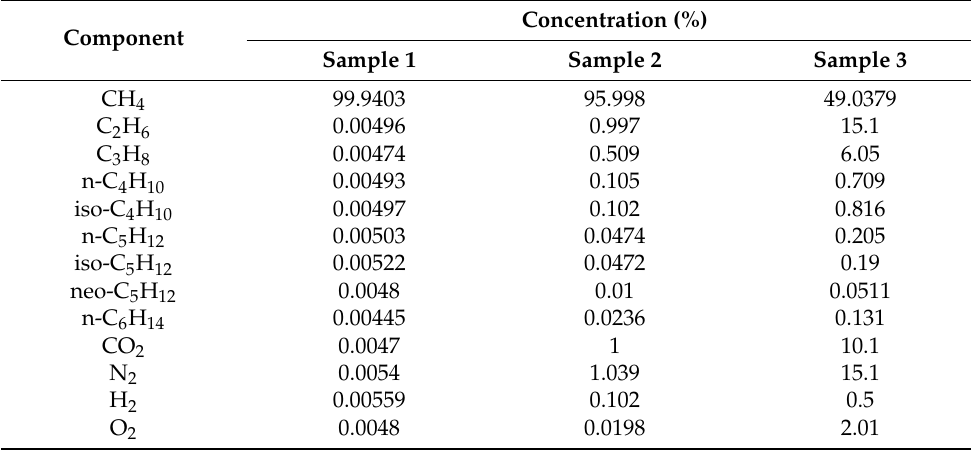
Table 1. Composition of natural gas samples used.